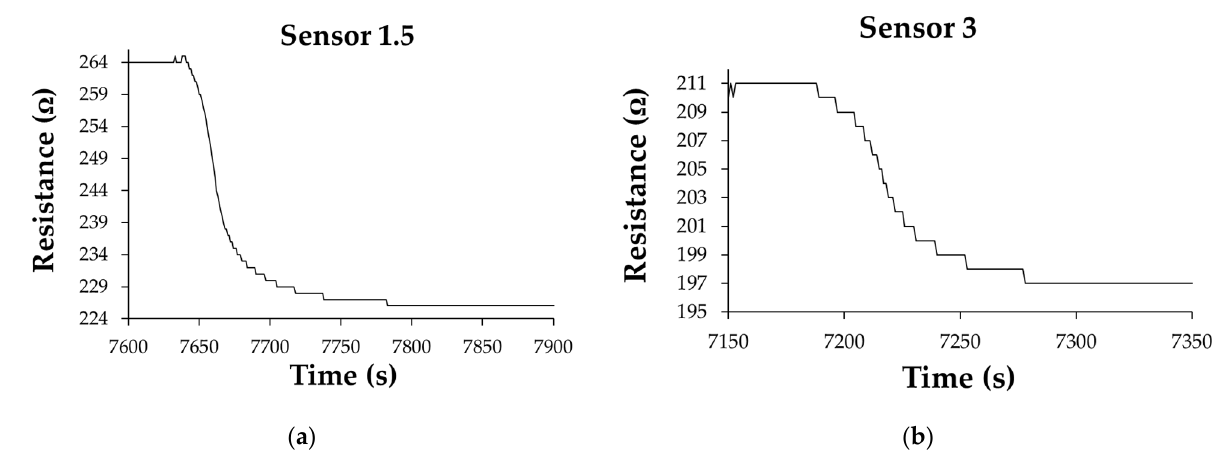
Figure 11. Recovery times of the resistive sensor after the second cycle; the recovery time was measured from 100% to 0% RH (clean, dry nitrogen): ( a ) sensor “1.5” and ( b ) sensor “3”.